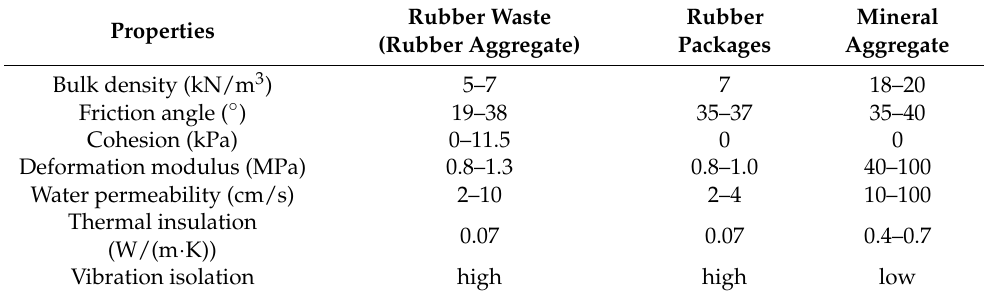
Table 2. Comparison of characteristics of recycled rubber materials with mineral aggregate